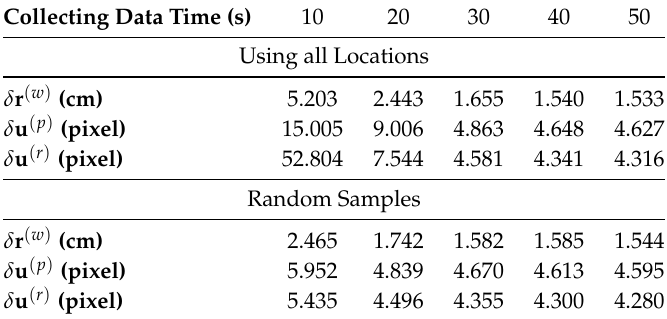
Table 1. The calibration results on Camera Network 1 (CN1) within 1000 experiments of the proposed method. δ r ( w ) , δ u ( p ) , δ u ( r ) , and δ u ( rr ) denotes the triangulation error, projection error, reprojection error, and relative reprojection error, respectively.